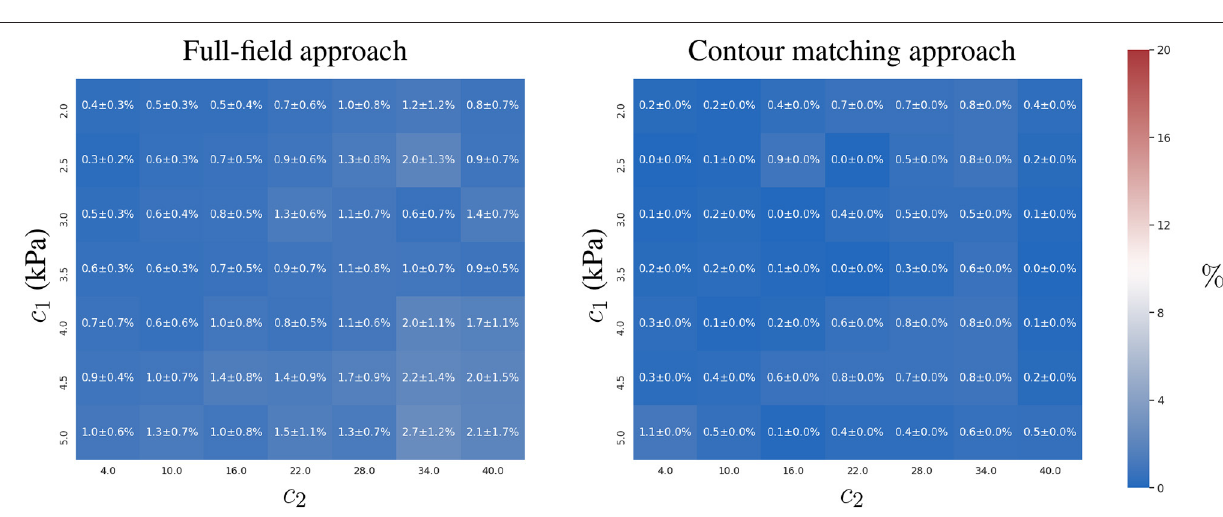
FIGURE 7 | Mean and standard deviation of the relative errors for recovering ground truth intra-ventricular pressure using the full-field tracking and contour matching approaches and an intra-ventricular pressure of p = 0.9 kPa with Gaussian noise ( σ = 1 mm ≈ 2 pixels) in the observations. Refer to the Supplementary Material for details of the relative errors for other intra-ventricular